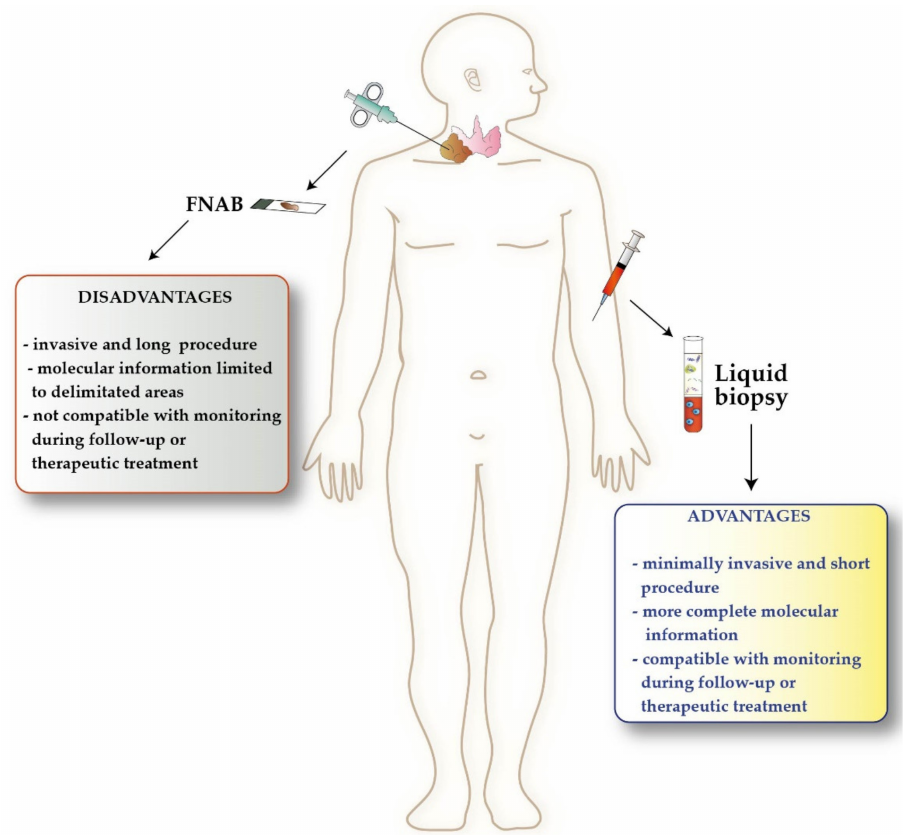
Figure 1. Advantages of liquid biopsy over tissue biopsy in thyroid cancer. FNAB, fine needle aspiration